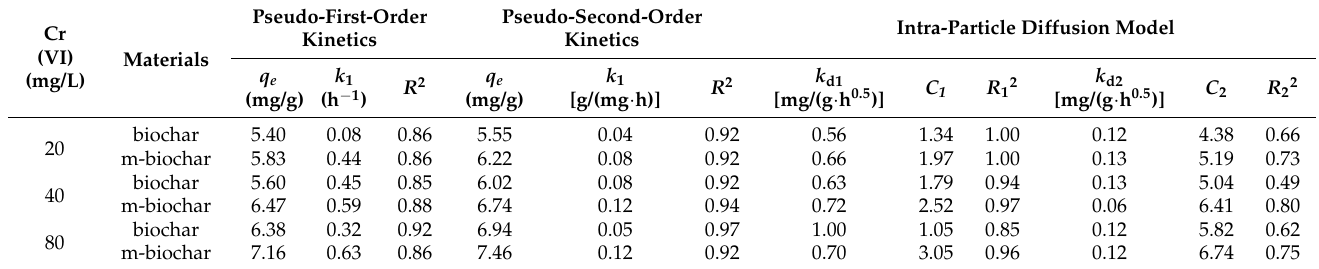
Intra-Particle Diffusion